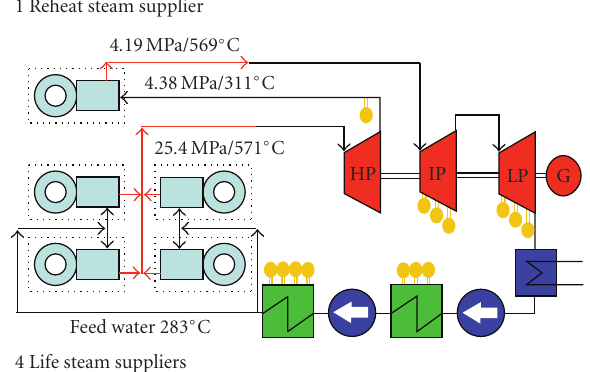
Figure 3: Matching pattern 1 of MHTGR-250 SC plant.